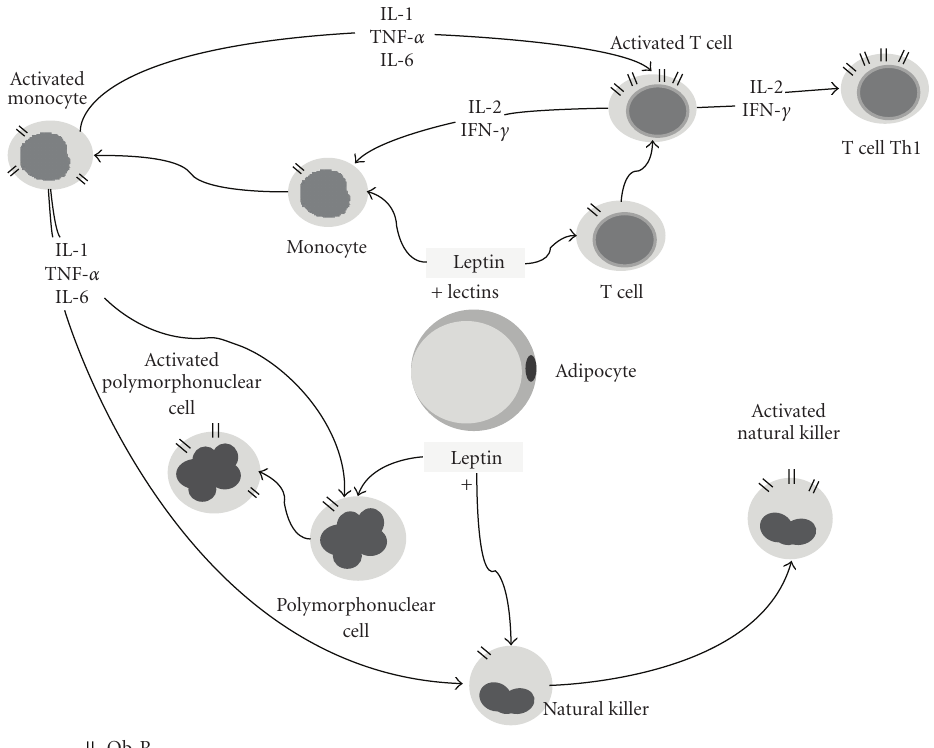
Figure 1: Role of leptin activating immune-competent